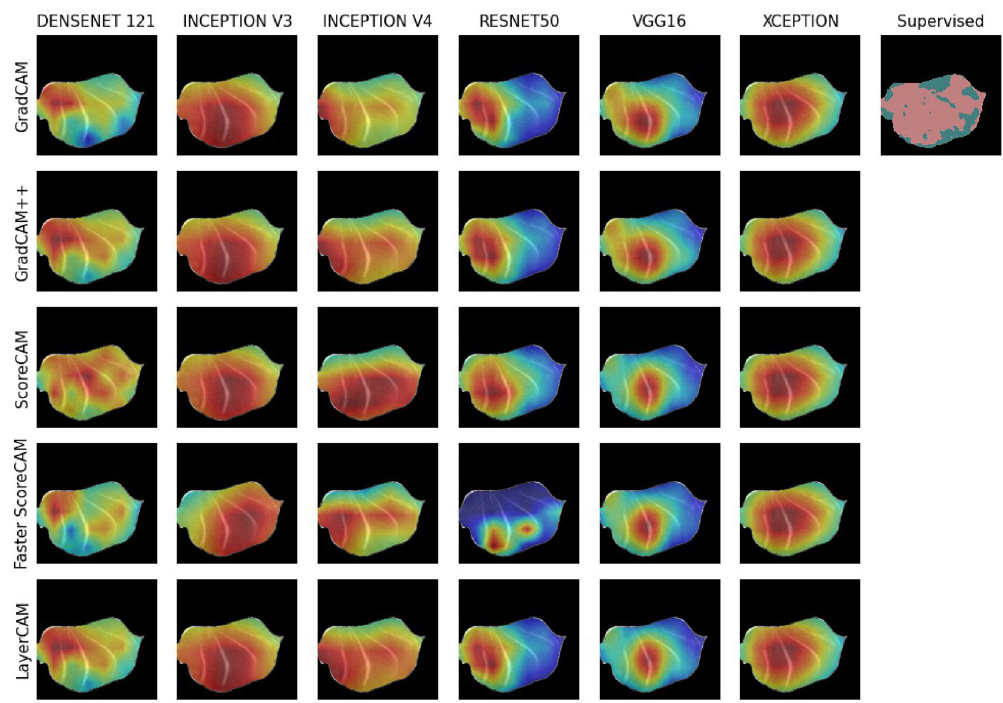
Figure 2. Overview of damaged tissue (y = 1) of different CAM methods and CNN backbone combinations on the same sample. The plot on the top right shows the supervised classification in which the dark pink illustrates the damaged